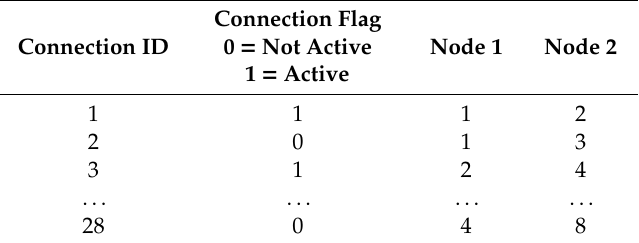
Table 1. Connectivity Matrix for 8-node cells.